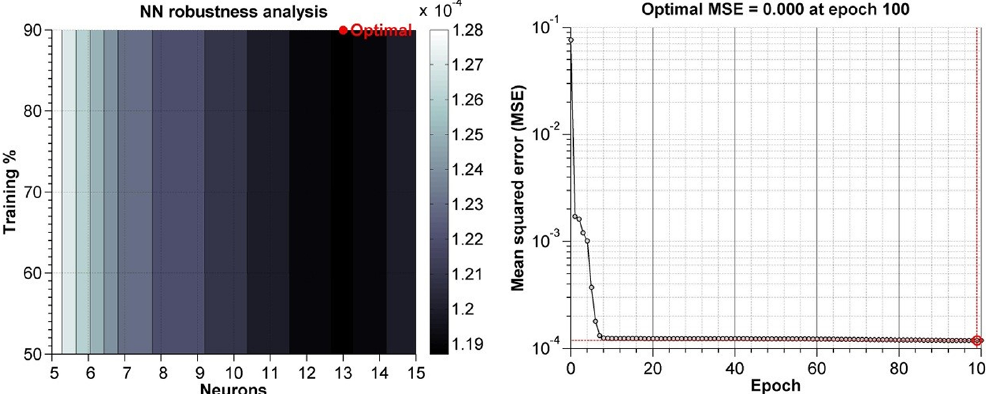
Figure 3. Left: the robustness analysis on the grid of 100 NN models using the minimum validation mean squared error (MSE) as the criterion for selection of the optimal NN architecture (which was found to have 13 hidden neurons and a training:validation data split of 90%:10%). Right: the progress of the NN training of the optimal architecture with back-propagation iteration out to 100 iterations “epochs”, where MSE < 1 . 0 e − 4 .